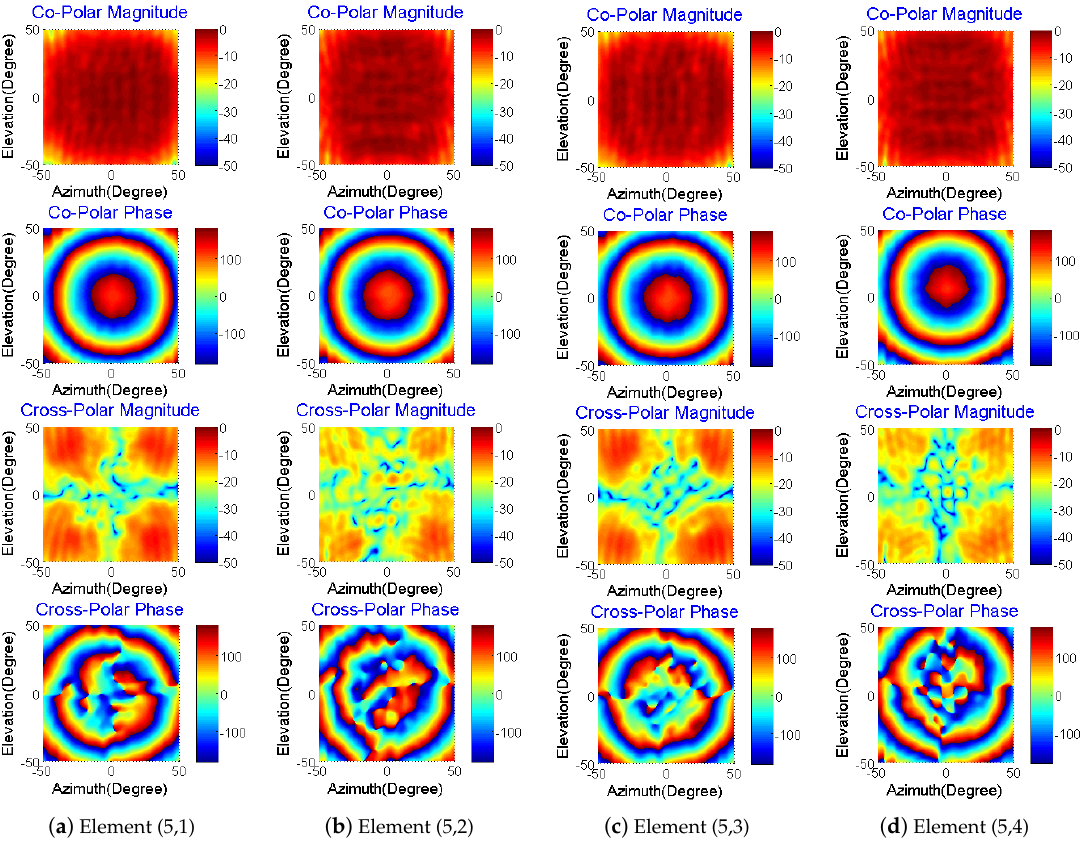
Figure 10. Measured AEPs of the (5,1) ( a ), (5,2) ( b ), (5,3) ( c ) and (5,4) ( d ) elements in the eight-by-eight planar phased array antenna; co-polar magnitude in dB (first row), co-polar phase in degrees (second row), cross-polar magnitude in dB (third row) and cross-polar phase in degrees (forth